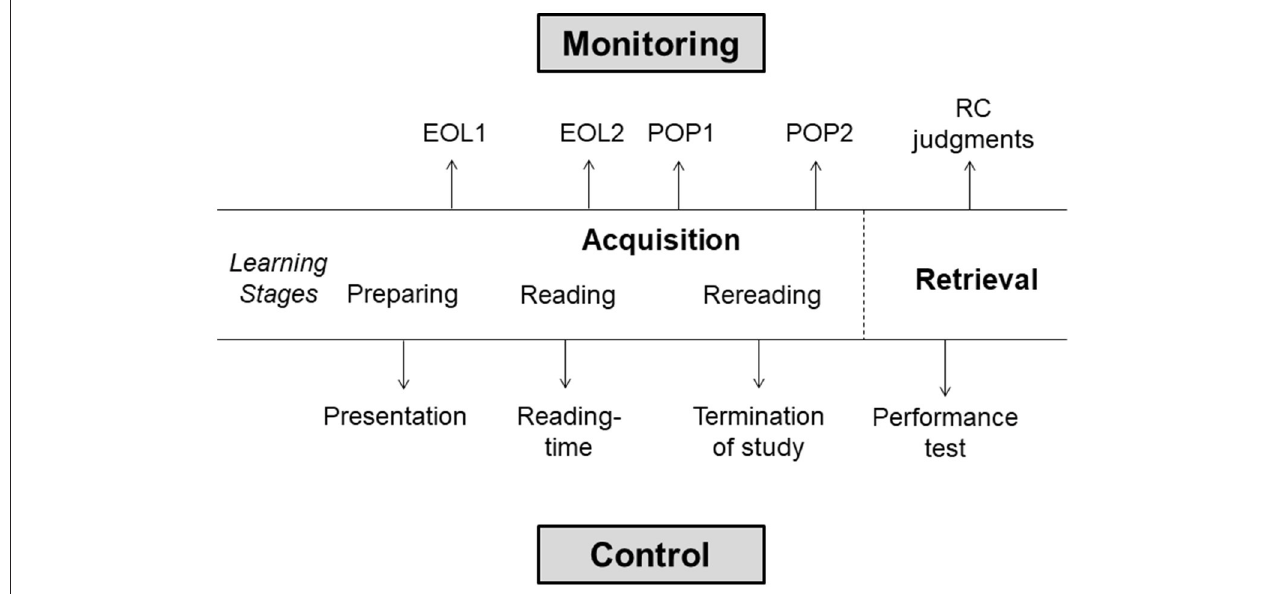
FIGURE 3 | Procedure of the study. The procedure was the same for each of the two texts; performances were captured after acquisition of both texts.